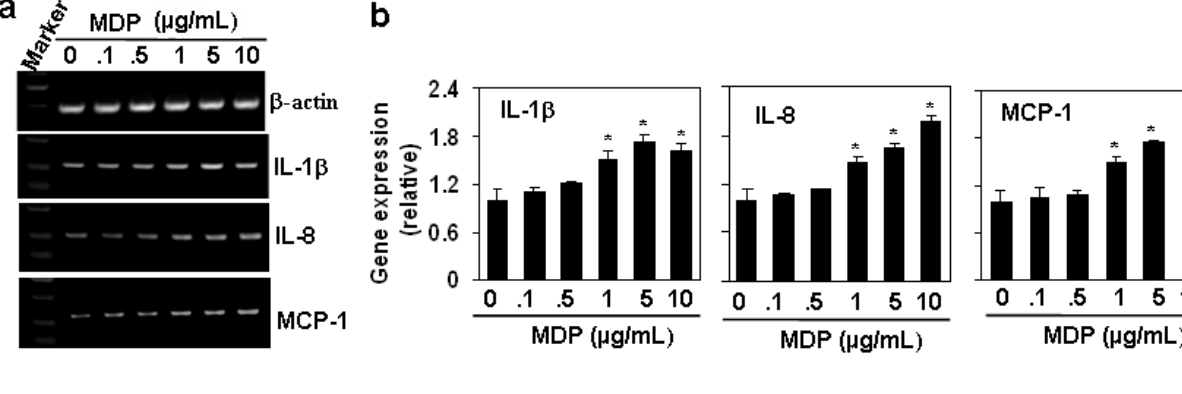
Figure 5. MDP induces the gene expression of pro-inflammatory cytokines. ( a ) The effect of MDP on the gene expression of pro-inflammatory cytokines. HAECs were treated with the indicated concentration of MDP for 24 h. The gene expression of pro-inflammatory cytokines was measured by RT-PCR. β -actin gene expression was measured as loading control; ( b ) The quantitation of cytokine gene expression in ( a ) by qRT-PCR. * P < 0.05 compared with the control groups, n = 3 in each